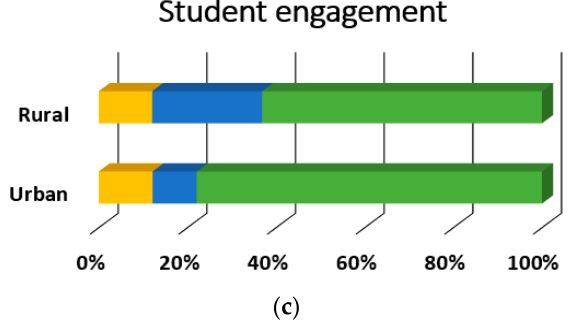
Figure 7. Nutrition, Operations, Administration, and Communications and Marketing training topic needs that significantly differed by school locale, n = 364 (rural, n = 133; urban, n = 231). Described below for each panel are the χ 2 and p -values. ( a ) Procurement strategies (bidding process and writing specifications, purchasing co-operatives, etc.), χ 2 (2) = 15.9, p < 0.001, Cramer’s V = 0.21; ( b ) Key performance indicators to make data-driven decisions (e.g., average daily participation, meal equivalents, cost per meal equivalent, break-even point), χ 2 (2) = 16.2, p < 0.001, Cramer’s V = 0.21; ( c ) Increasing student engagement and involvement, χ 2 (2) = 14.6, p = 0.001, Cramer’s V = 0.20.